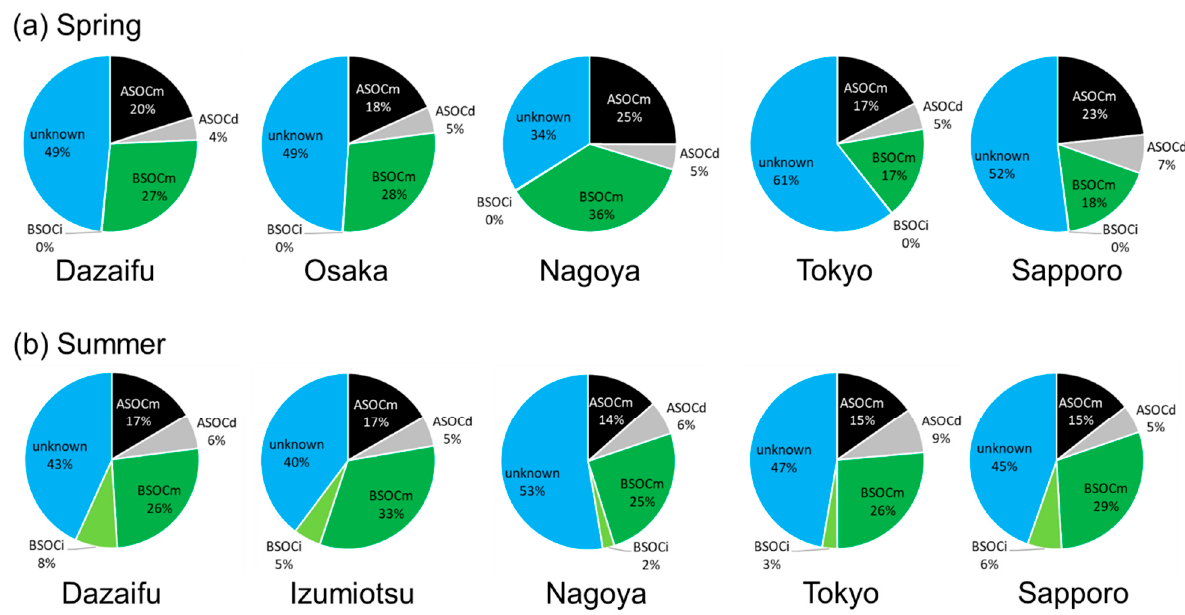
Figure 4. Fractions of mono-aromatic, di-aromatic, monoterpene-derived, and isoprene-derived SOCs (ASOCm, ASOCd, BSOCm, and BSOCi, respectively) in WSOC during ( a ) spring and ( b ) summer at each site. Table 6. Estimated SOC concentrations (ng/m 3 ) during spring and summer presented herein and those presented by [61–64] in China.